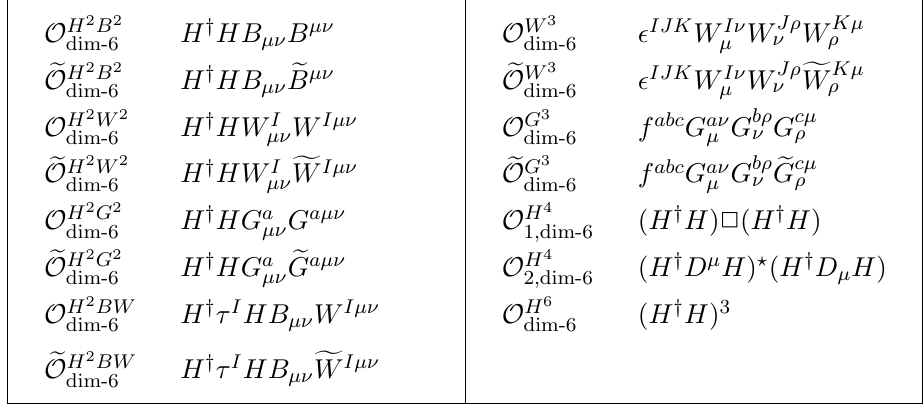
Table 3 . Bosonic operators at dimension six in the